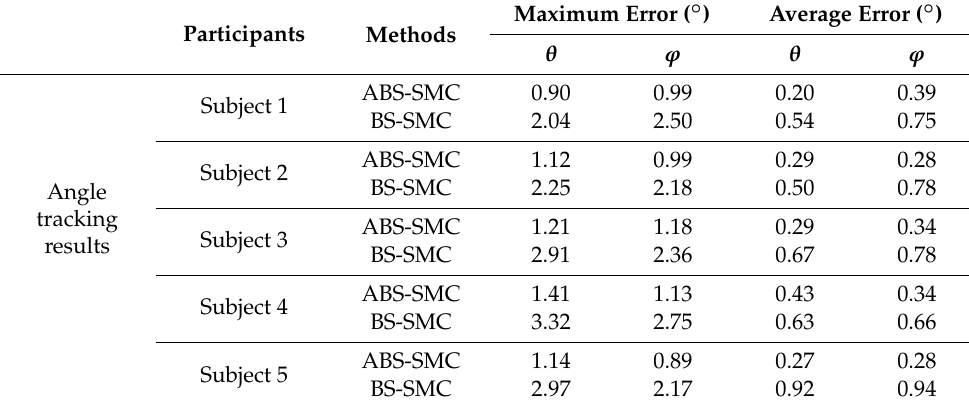
Table 5. End-effector angle tracking errors under different control methods (with five subjects).